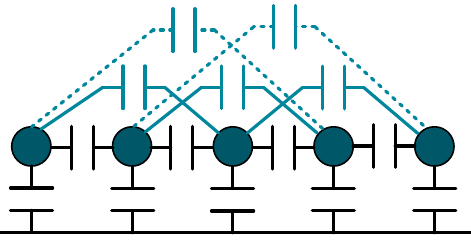
Figure 2. Self-capacitance of a single layer on the spacing between windings.